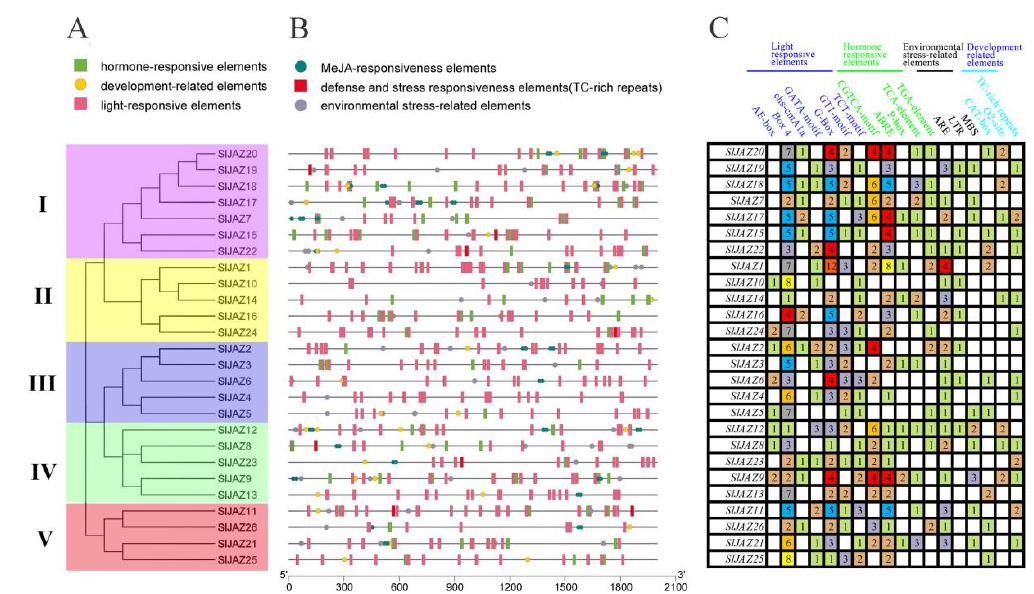
Figure 4. Distribution of cis-acting elements in the promoter regions of SlJAZ genes. ( A ) Phylogenetic tree of JAZ gene family members in tomato. The different background colors correspond to the different branches. ( B ) Distribution of cis-acting elements in the promoter region (−2000 bp of the initiation codon) of SlJAZ genes. The different colored blocks represent the different types of cis-acting elements and their locations in each SlJAZ gene. ( C ) Statistics for the 18 cis-acting elements in the SlJAZ gene. The 18 types of cis-acting elements were divided into four categories. The different colors and numbers in the grid indicate the numbers of different cis-acting elements in these SlJAZ genes.